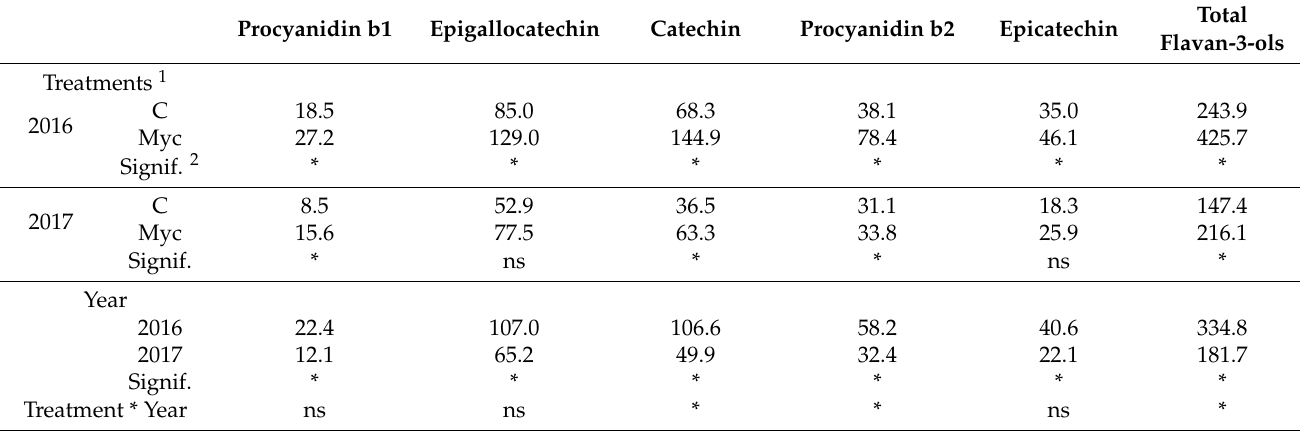
Table 6. Berry skin flavanols (mg kg − 1 of the dry weight of grape skin) in mycorrhized and control treatments.